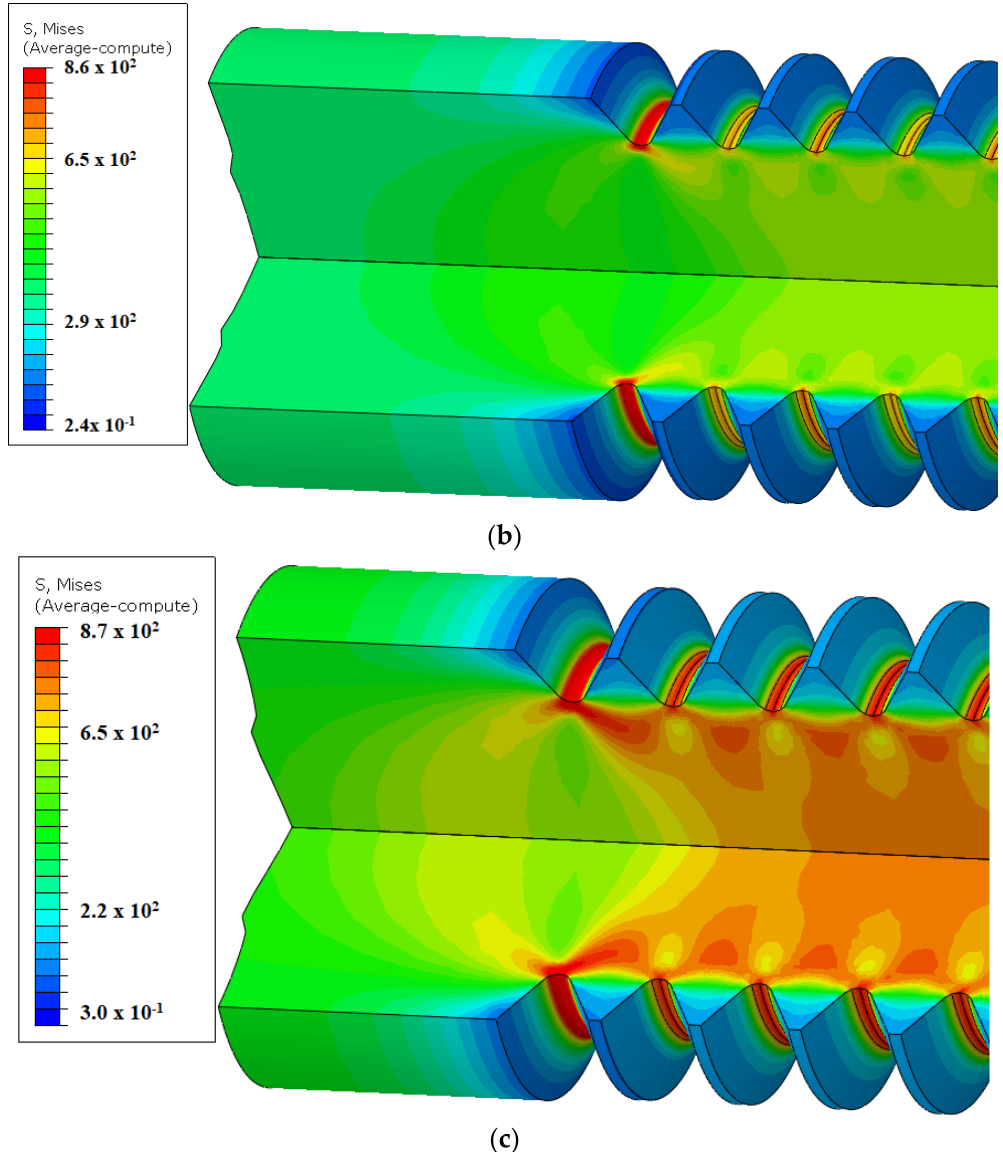
Figure 14. FEA for threaded specimens without nut interface. von Mises stress (MPa) for maximum nominal stress ( a ) 440.6 MPa (50% of the yield strength), ( b ) 616.8 MPa (70% of the yield strength), and ( c ) 793 MPa (90% of the yield strength).